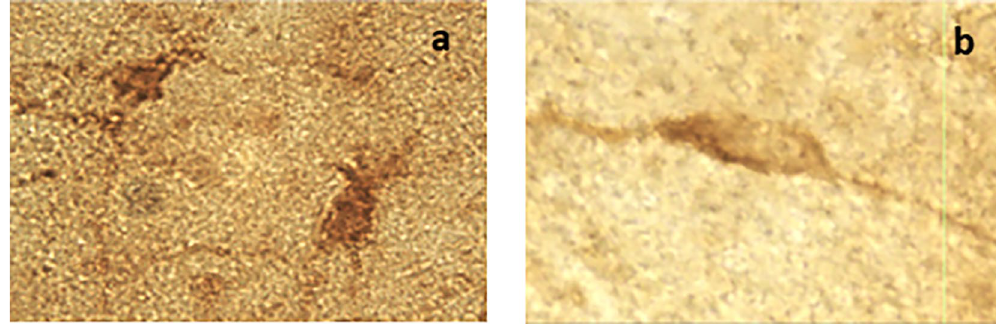
Figure 2. Example photomicrographs of DCX + cells with ( a ) multipolar and ( b ) bipolar morphologies. Images (not to scale) were captured at 100X